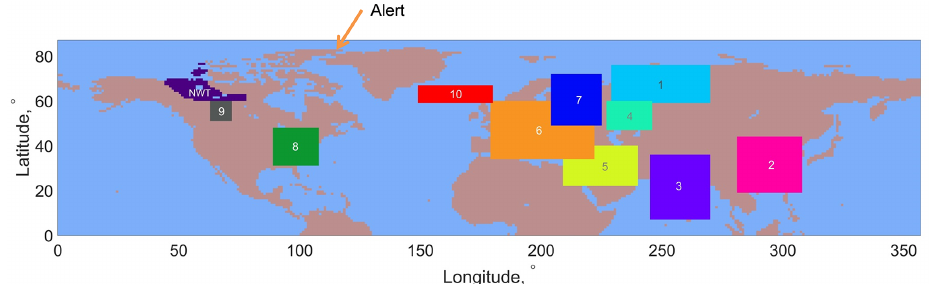
Figure 1. Map showing Alert and identifying regions referenced in FLEXPART analysis: (1) north-central Russia; (2) southeast Asia; (3) India; (4) western Russia; (5) the Middle East; (6) Europe; (7) northwest Russia; (8) eastern North America; (9) the Canadian Oil Sands; (10) Iceland and surrounding waters; Canadian Northwest Territories